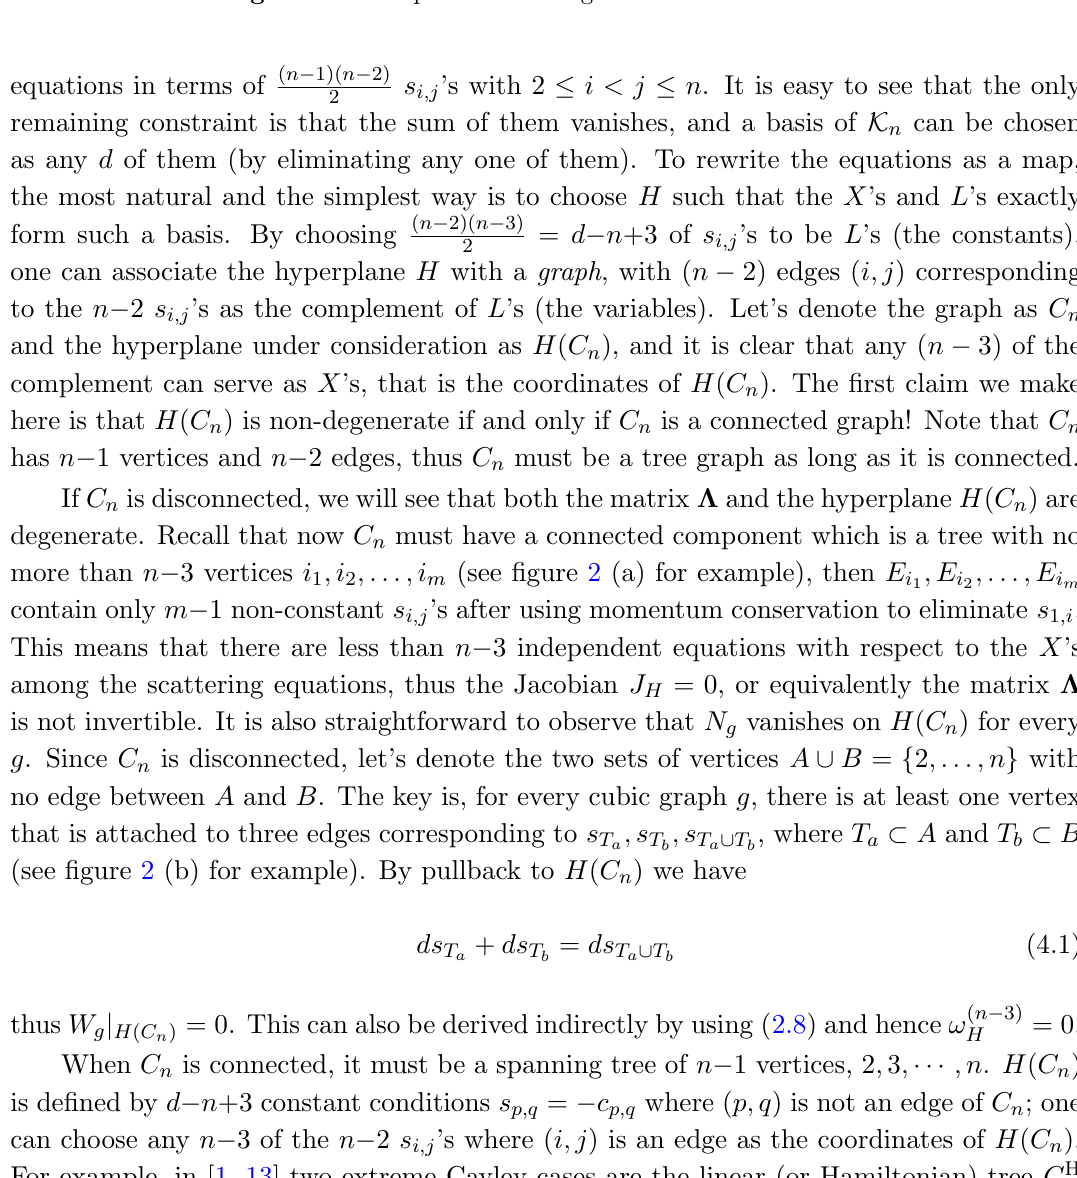
Figure 2. Examples of vanishing Jacobian and cubic